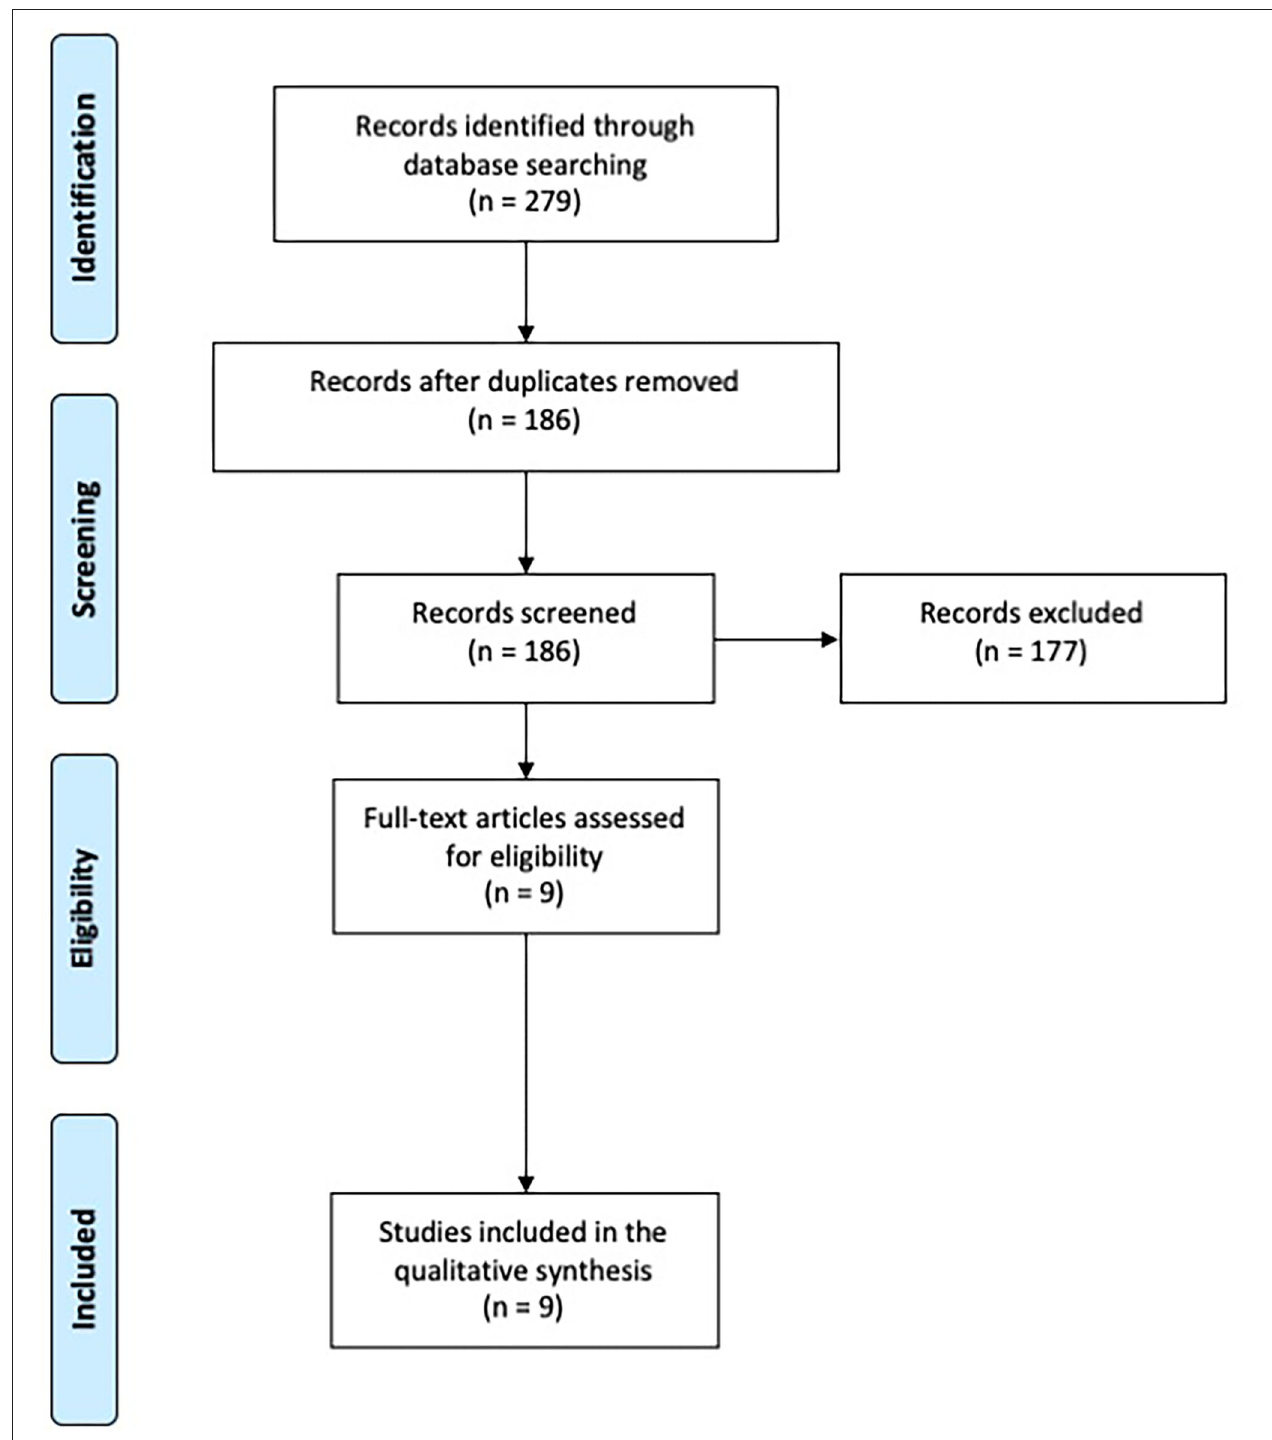
FIGURE 1 | PRISMA diagram of the study (www.prisma-statement.org).